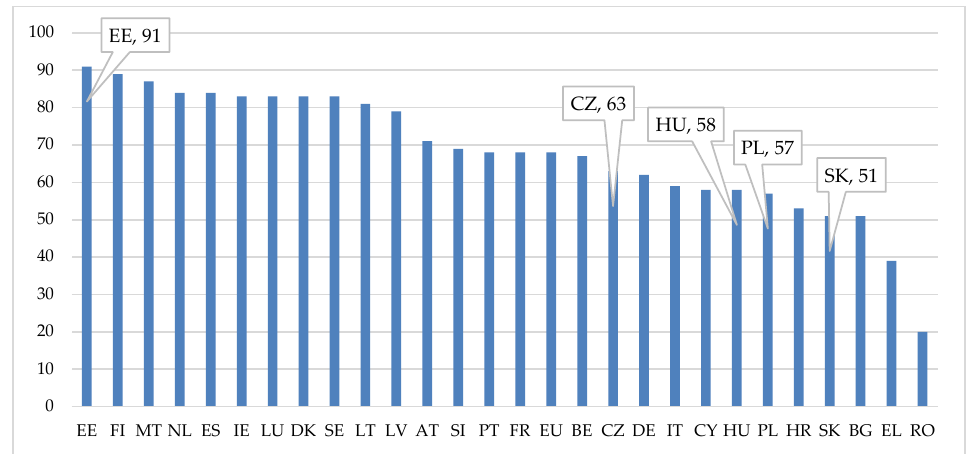
Figure 10. Digital Economy and Society Index (DESI) 2022, digital public services. Source: Authors’ compilation, according to [71] and cumulative data.